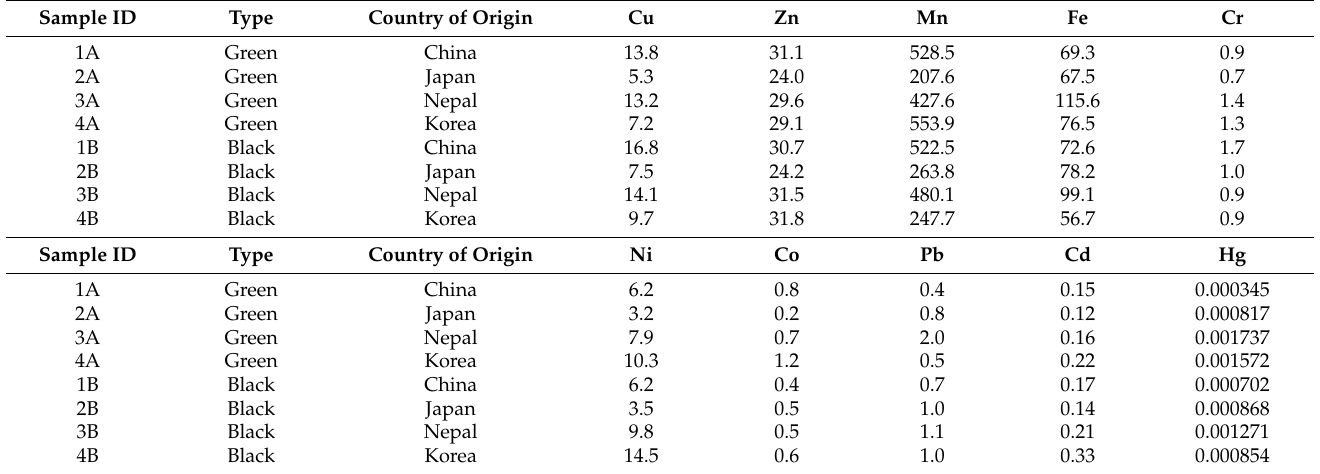
Table 5. The concentration of heavy metals in green and black teas.